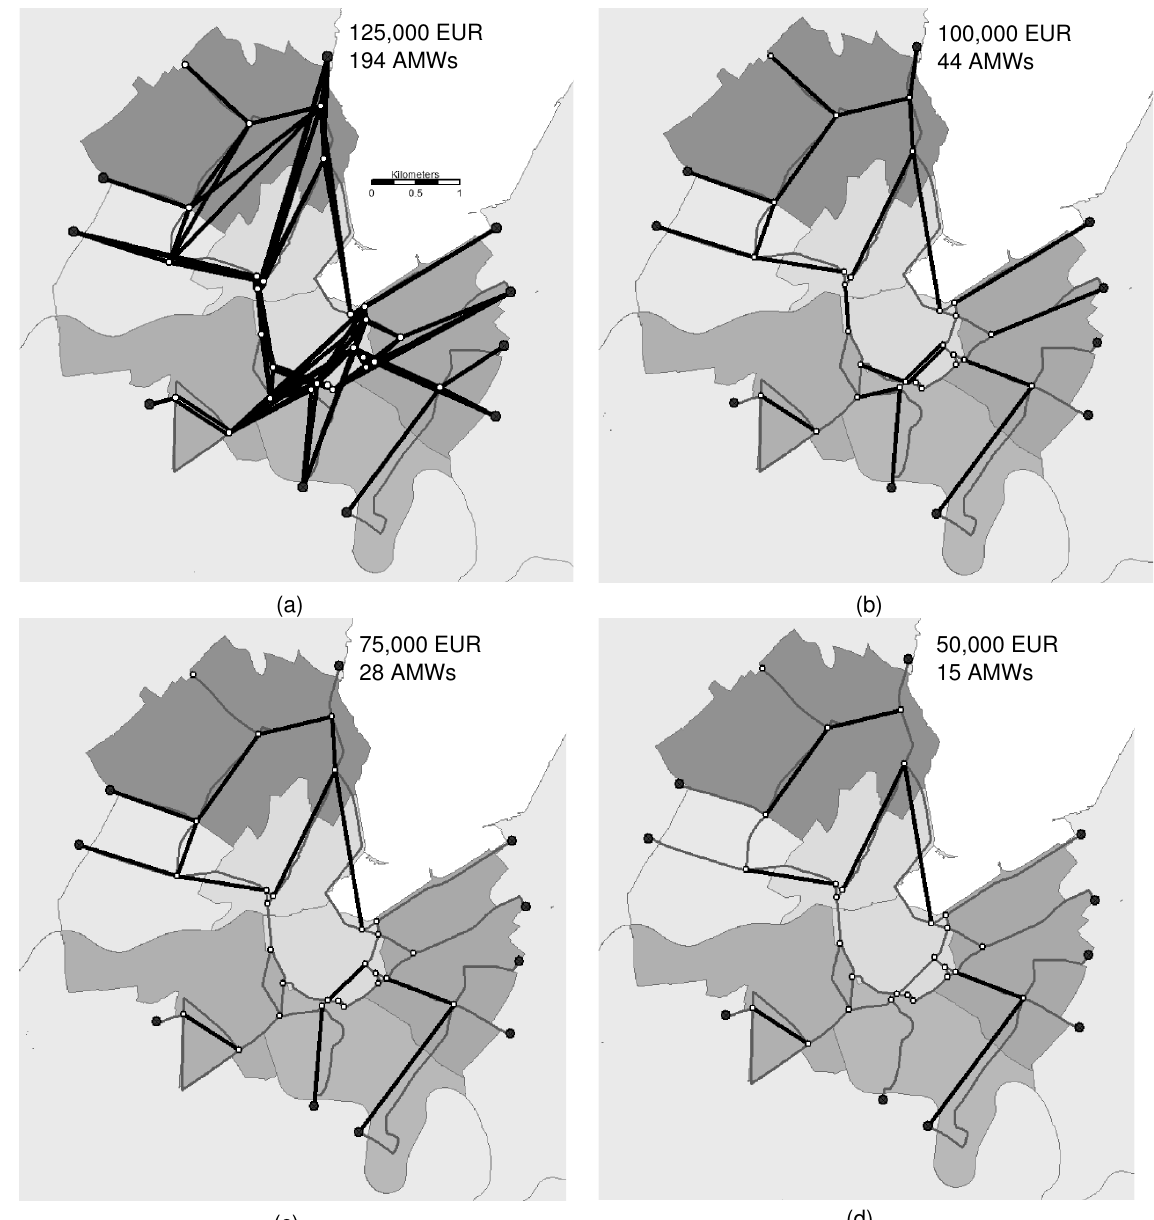
Figure 7. Case study results. Road network arcs equipped with AMWs for different operational